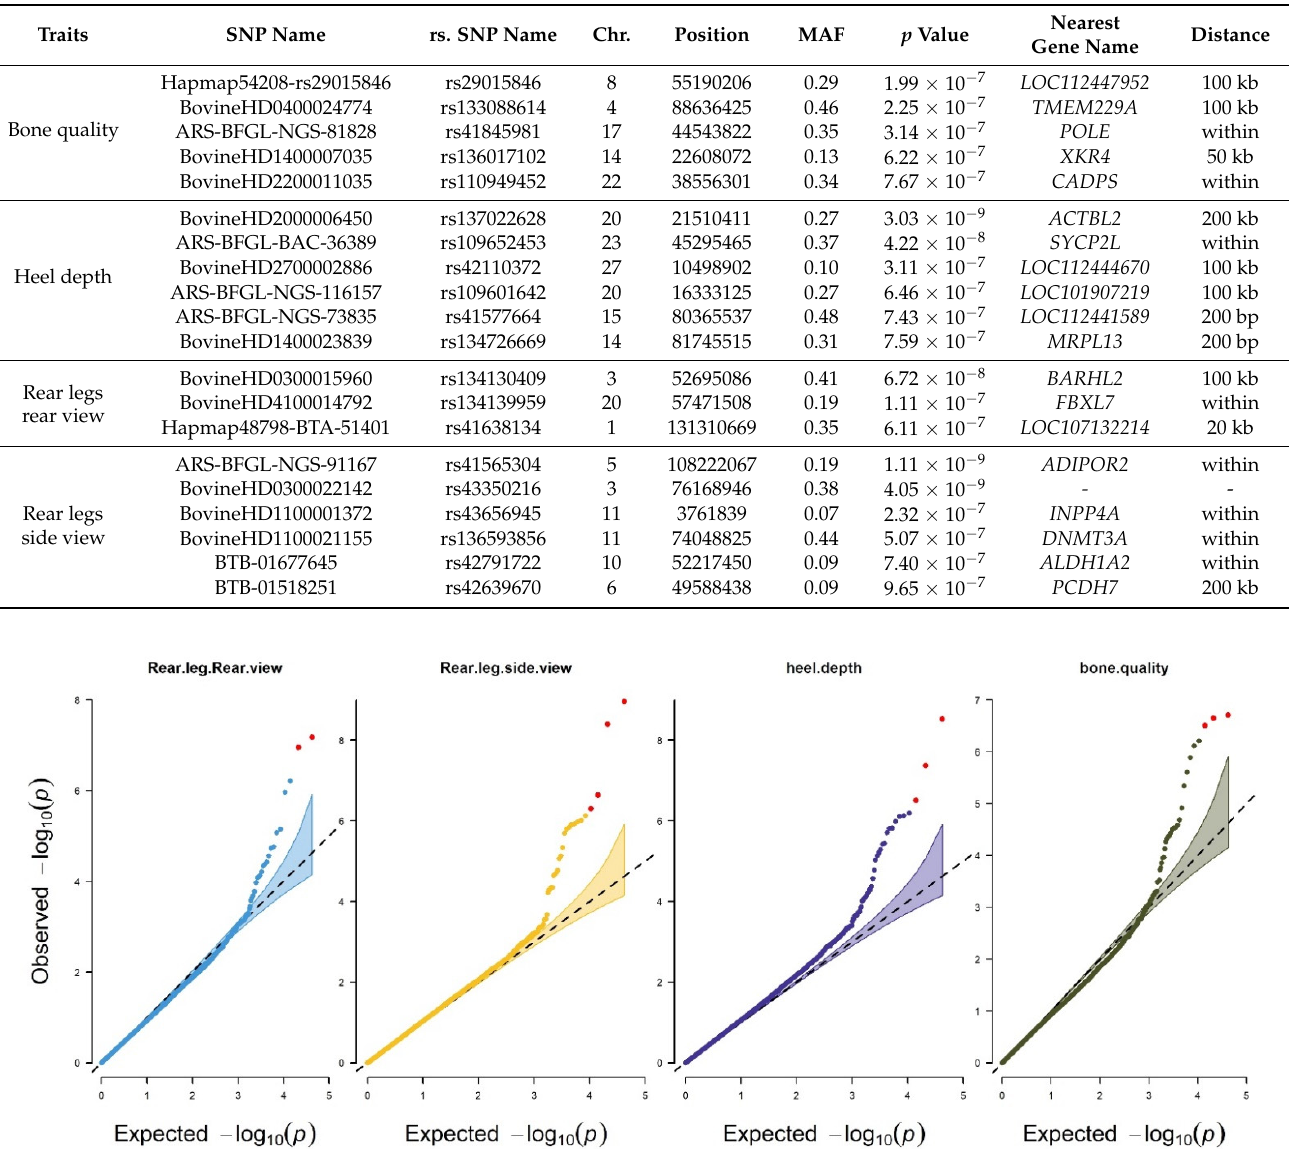
Figure 3. Quantile–quantile (Q–Q) from GWAS for feet and leg traits in Chinese Holstein cattle. Q–Q plot showing the late separation between observed and expected values. The red lines indicate the null hypothesis of no true association. Deviation from the expected p value distribution is evident only in the tail area for each trait, indicating that population stratification was properly controlled.